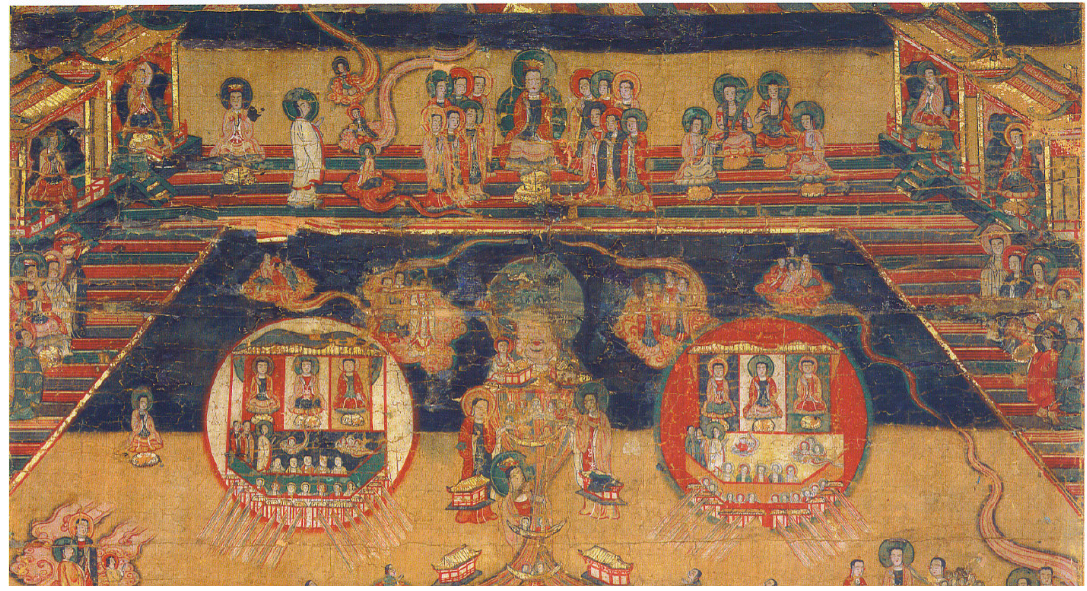
Figure 4. The New Aeon and Liberation of light, that is, triad of the Sun, Moon and a third divine figure between them (Yoshida and Furukawa 2015, Plate 5).